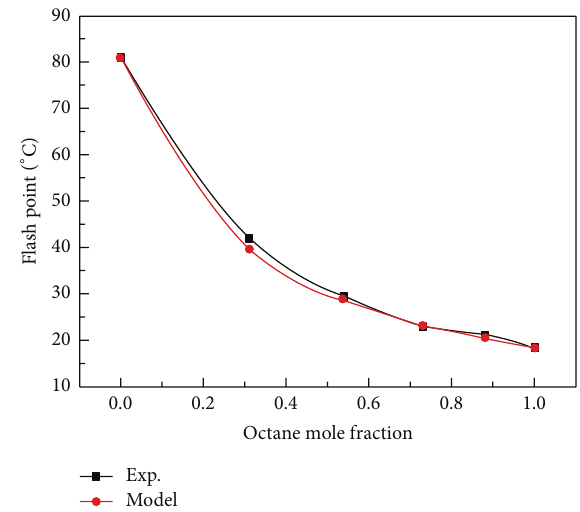
Figure 1: Flash point of octane + dodecane with different mole fractions.